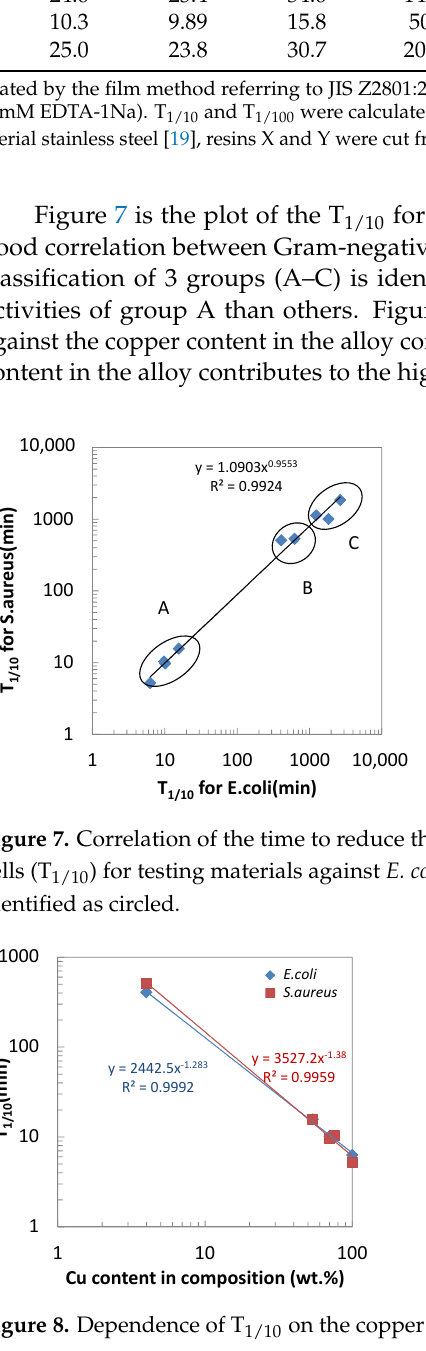
Figure 8. Dependence of T 1/10 on the copper content in the alloy composition.